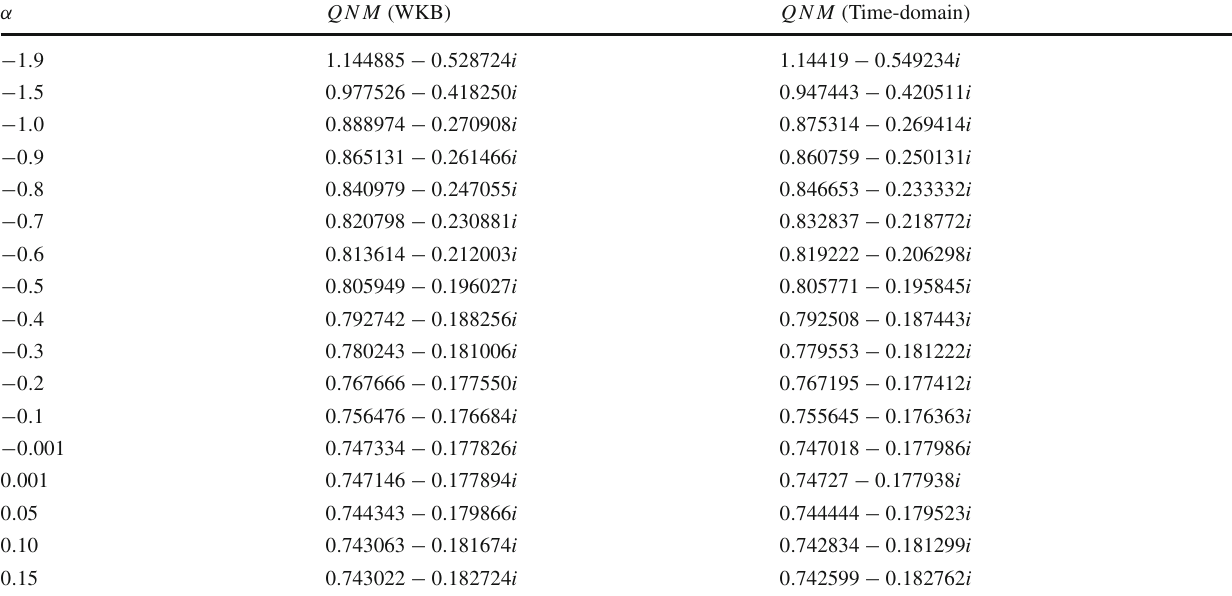
Table 2 Gravitational quasinormal modes the vector (axial) type for various values of the coupling constant α in the stability sector; (cid:11) = 2. At α ≈ − 1 . 5 and smaller there are two concurrent modes in the spec-